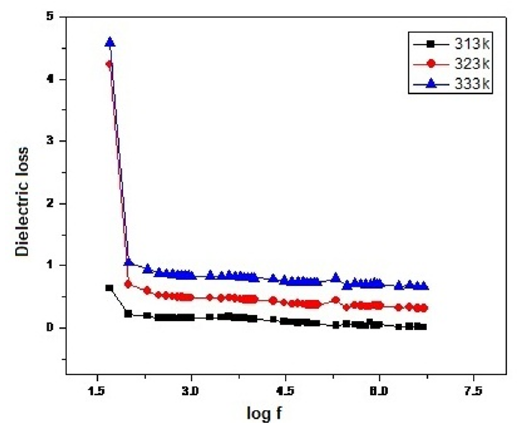
Figure 9. Dielectric loss vs log of frequency of MMTG